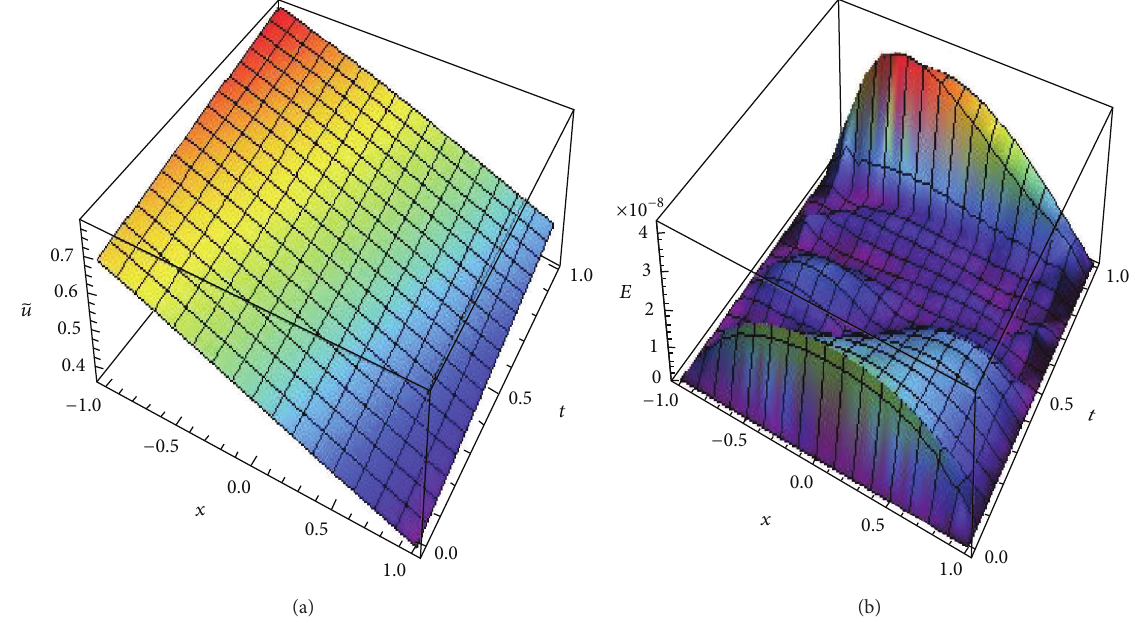
Figure 1: The result of the L-GL-C method at 𝛾 = 10 −2 and 𝑁 = 20 . (a) The approximate solution. (b) The absolute error.